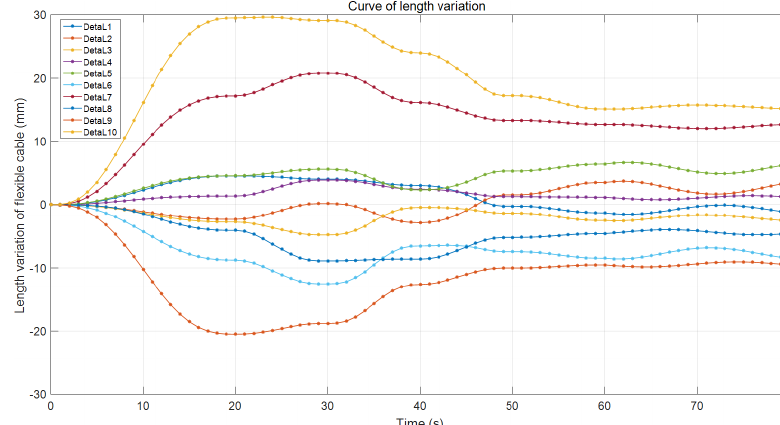
Figure 9. Flexible cable length variation curves (1).